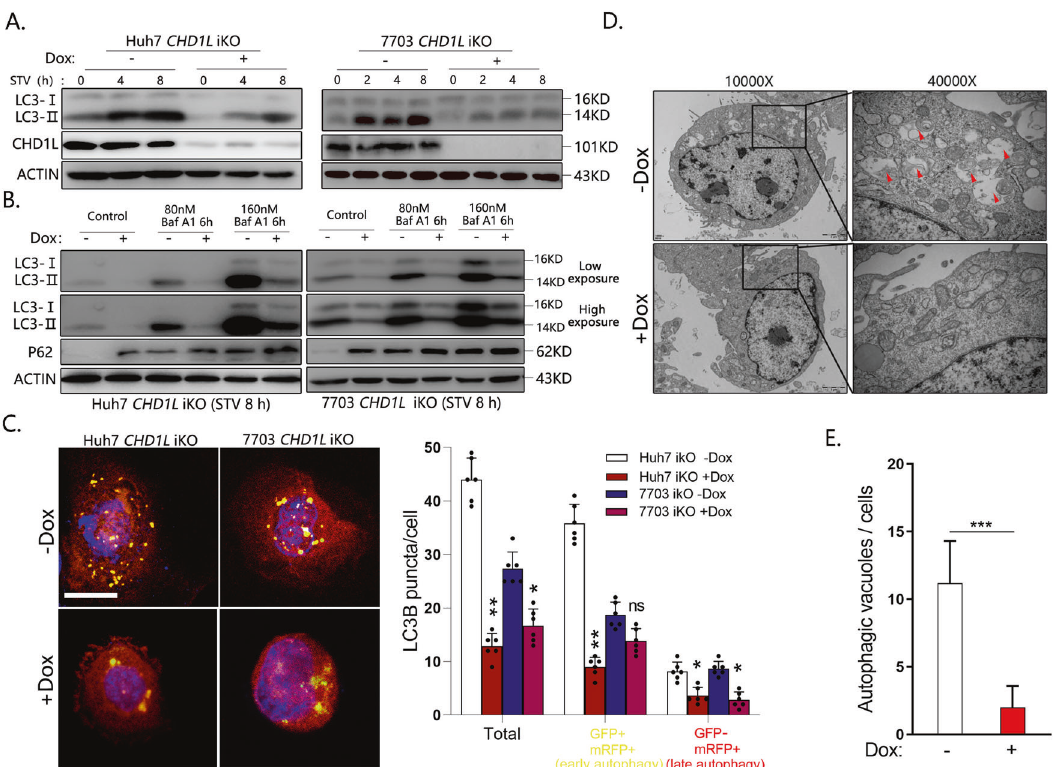
Fig. 3 Knockout of CHD1L signi fi cantly blocked the autophagic fl ux induced by starvation in HCC cells. A WB analysis for starvation- induced changes in LC3 conversion in Dox ( − / + )-induced Huh7 and QGY-7703-iKO cells. B WB analysis of changes induced by CHD1L ablation in LC3 conversion in Huh7 and QGY-7703-iKO cells treated with Baf A1 at indicated concentration. C Representative images showing starvation-induced mRFP-LC3 and GFP-mRFP-LC3 puncta accumulation in response to CHD1L deletion in Huh7 and QGY-7703-iKO cells. Quanti fi cation of mRFP-LC3 and GFP-mRFP-LC3 puncta per cell. Bar = 10 μ M (* p < 0.05; ** p < 0.01, ns No signi fi cant; Student ’ s t test; Data indicate mean ± SD; n = 5). D Ultrastructural evidence of autophagy induced by starvation in the indicated cells with CHD1L expression or ablation. The AVd indicate late/degradative autophagolysosomes. Magni fi cation ×10,000 – 40,000, scale bar represents as shown. E Quanti fi cation for autophagic vacuoles as described in “ Materials and methods ” . (*** p < 0.001, Student ’ s t test; Data indicate mean ± SD; n = 10). Images/immunoblots are representative of three independent